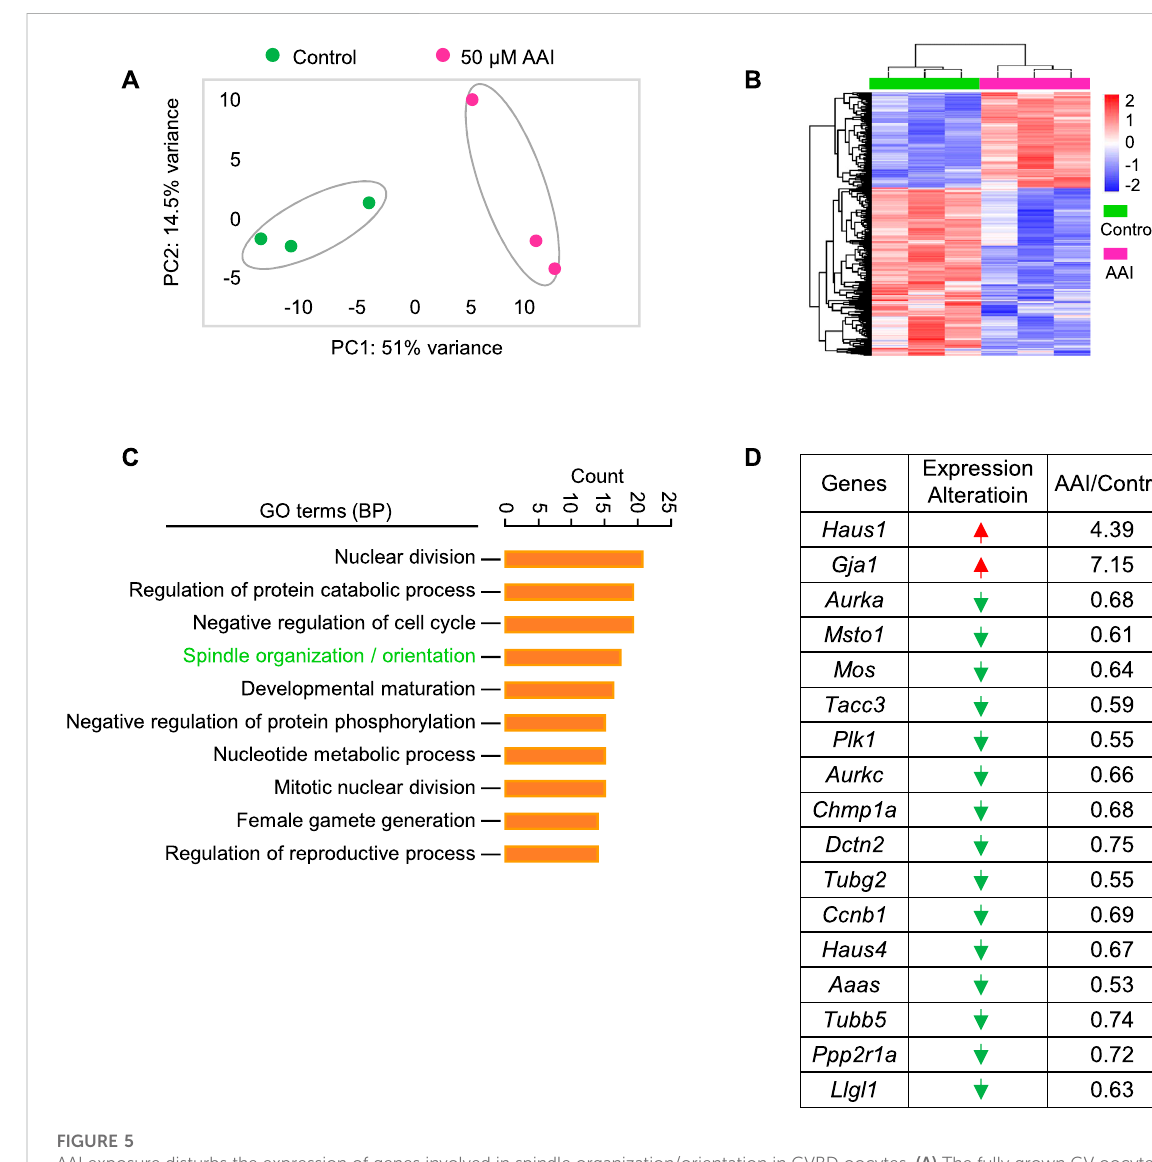
chromosome misalignment was also observed (0 μ M: 22.62%; To further understand how AAI exposure impairs spindle organization in MI oocytes, RNA-seq was performed using GVBD oocytes that matured in vitro in the presence or absence of AAI (Figure 5A). In both control and AAI treatment groups, the average correlation coef fi cient of three repeats in each group was 0.99. In total, 20,362 and 20,620 genes were detected in the control and 50 μ M AAI treatment groups,